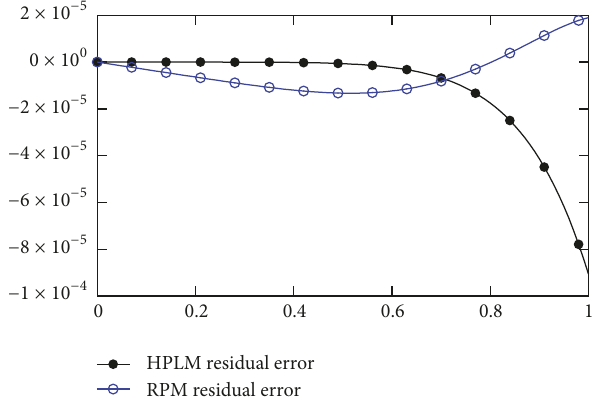
Figure 3: Comparison of residual errors of HPLM and RPM for Reynolds number 𝑅 = 0.05 .